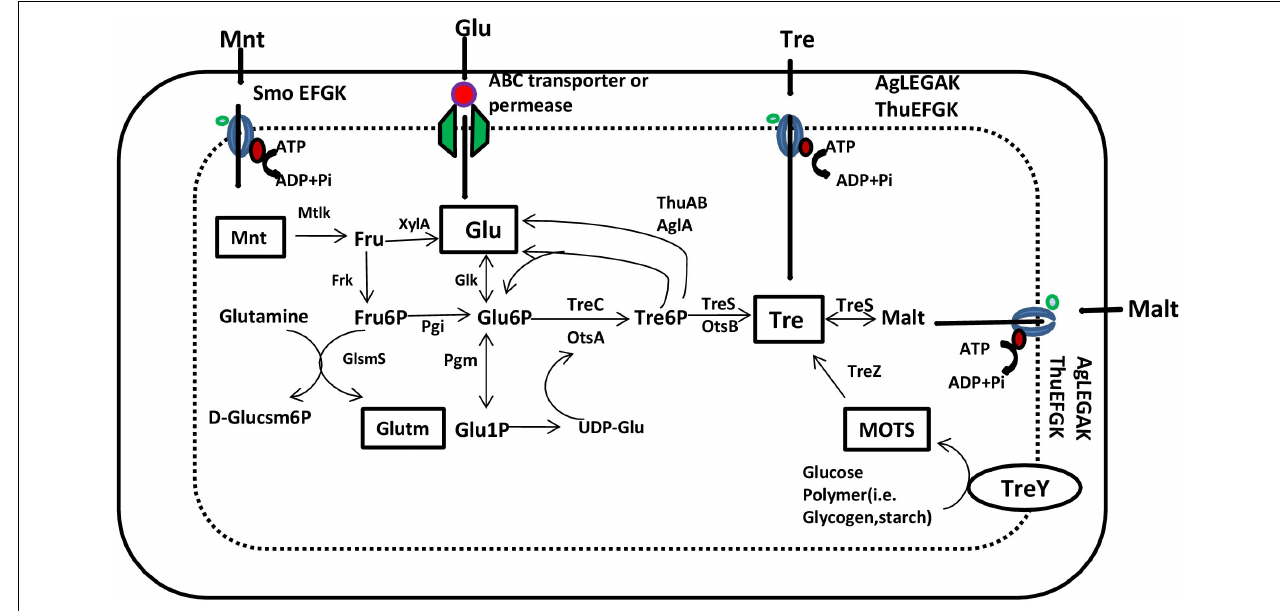
FIGURE 1 | Scheme of trehalose metabolism in Rhizobium etli based on the annotated genome. Glu, D -glucose; Glu6P, D -glucose-6-phosphate; Glu1P, D -glucose-1-phosphate; Glutm, D -glutamate; D -Glucsm6P, D -glucosamine-6-phosphate; Fru, D -fructose; Fru6P, D -fructose-6-phosphate; Malt, maltose; Mnt, mannitol; MOTS, maltoolygosyltrehalose; Tre, trehalose; TreP, trehalose-6-phosphate; AlgEFGAK and ThuEFGK, putative trehalose/maltose/sucrose ABC transporters; GlmS, glucosamine-6-phosphate synthase; Mtlk, mannitol 2-dehydrogenase; Frk, fructokinase; OtsA, trehalose-6-phosphate synthase; OtsB, trehalose-6-phosphate phosphatase; Pgi, phosphoglucose isomerase; XylA, xylose isomerase; TreC, trehalose-6-phosphate hydrolase; TreS, trehalose synthase; TreY, maltooligosyl trehalose synthase; TreZ, maltooligosyl trehalose trehalohydrolase; SmoEFGK, sorbitol/mannitol ABC transporter (source: Reina-Bueno et al.,